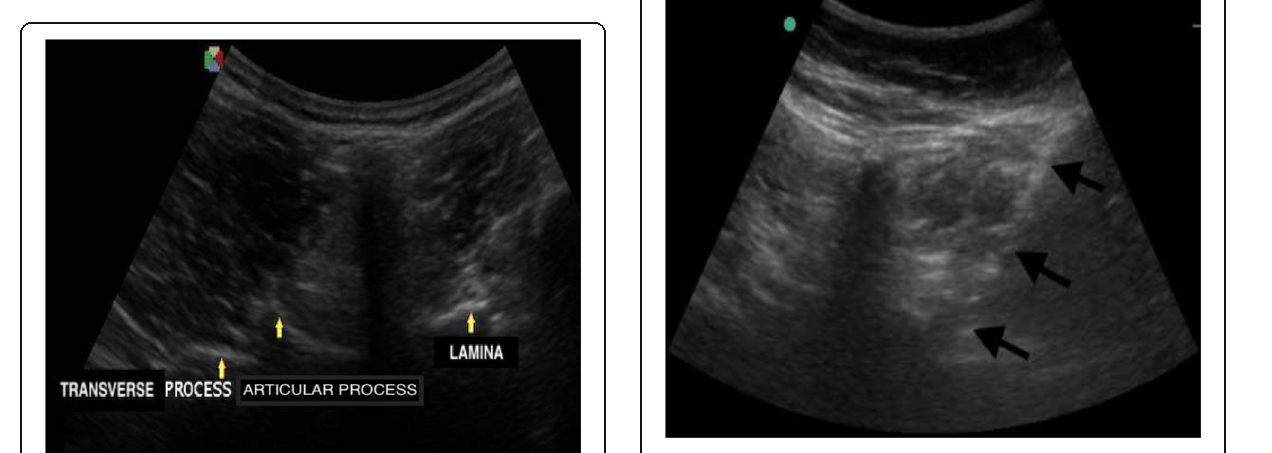
Fig. 9 Transverse axial sonogram of lumbar vertebra shows the entire path of the needle and needle tip anterior and medial to lateral border of articular